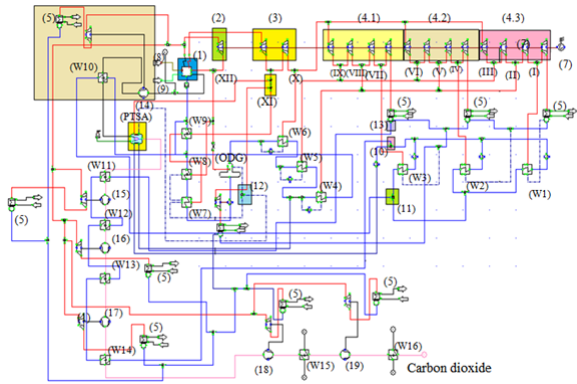
Fig. 1. The reference cycle model with integrated PTSA unit including CO 2 preparation system to liquid